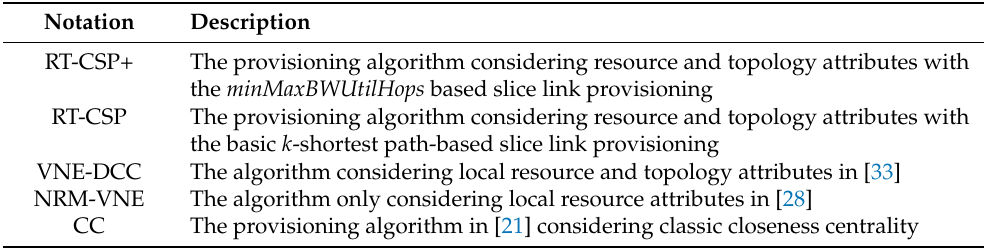
Table 3. Algorithms for